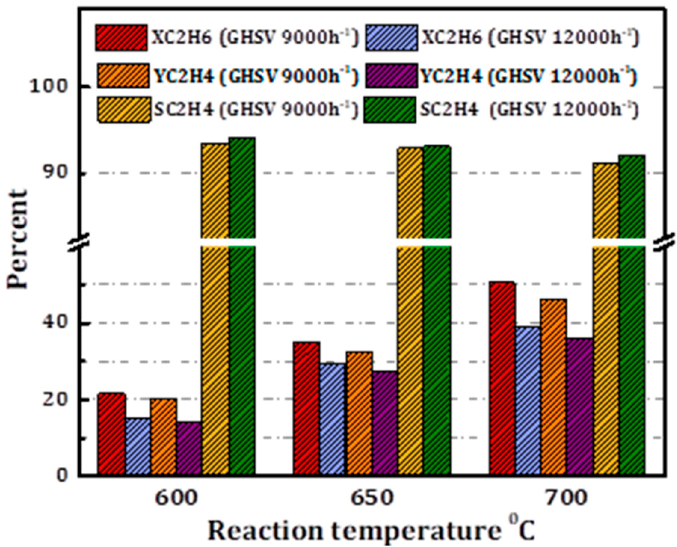
Figure 9. Effects of gas hourly space velocity (GHSV) on C 2 H 6 conversion and C 2 H 4 yield and selectivity for the Cr(4)/LPMS-130 catalyst at various reaction temperatures.